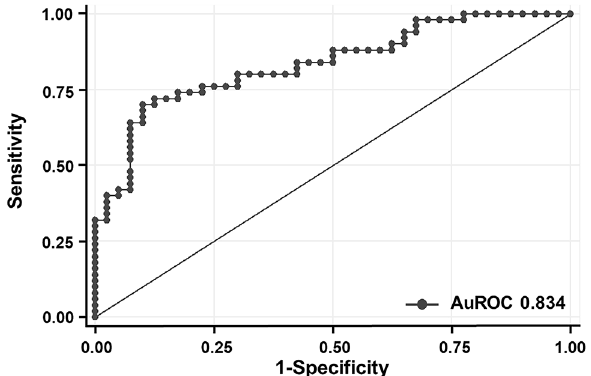
Figure 2. ROC and area under ROC (AuROC) for the prediction of osteogenic differentiation impairment in T2DM. The predictive model that included duration of diabetes, age and eGFR, showed the AuROC of 0.834, indicating a good predictive ability of this model to predict osteogenic differentiation impairment in patients with